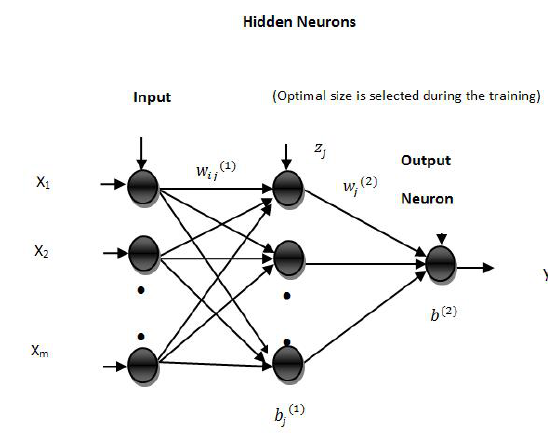
Figure 3. Multilayer feed forward